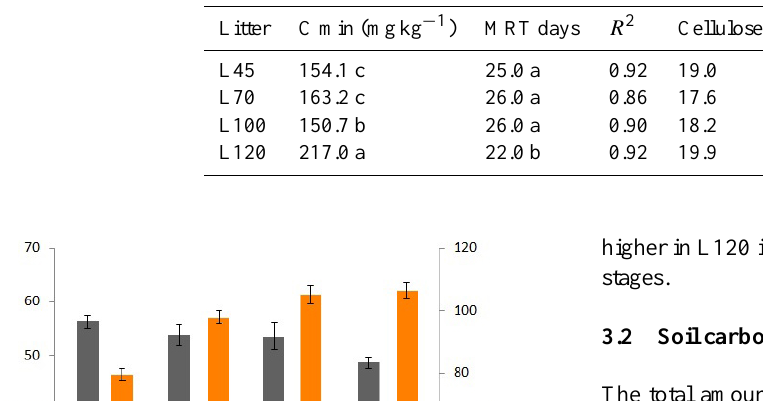
Table 2. Biomass composition (% of dry biomass) of litters in different stages of secondary succession (L45, L70, L100 and L120). Abbre- viations: ADF = acid detergent fibre, NDF = neutral detergent fibre, C min = readily mineralizable carbon, MRT = mean residence time. In the same column, different letters indicate differences for P ≤ 0 . 05.